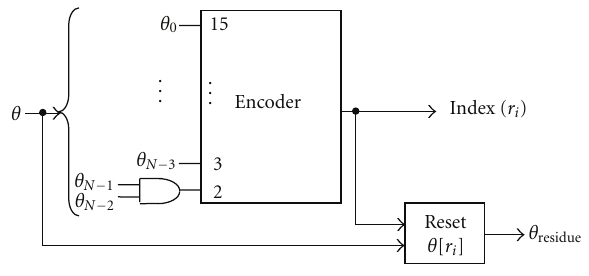
Figure 1: Micro-rotation sequence generator.